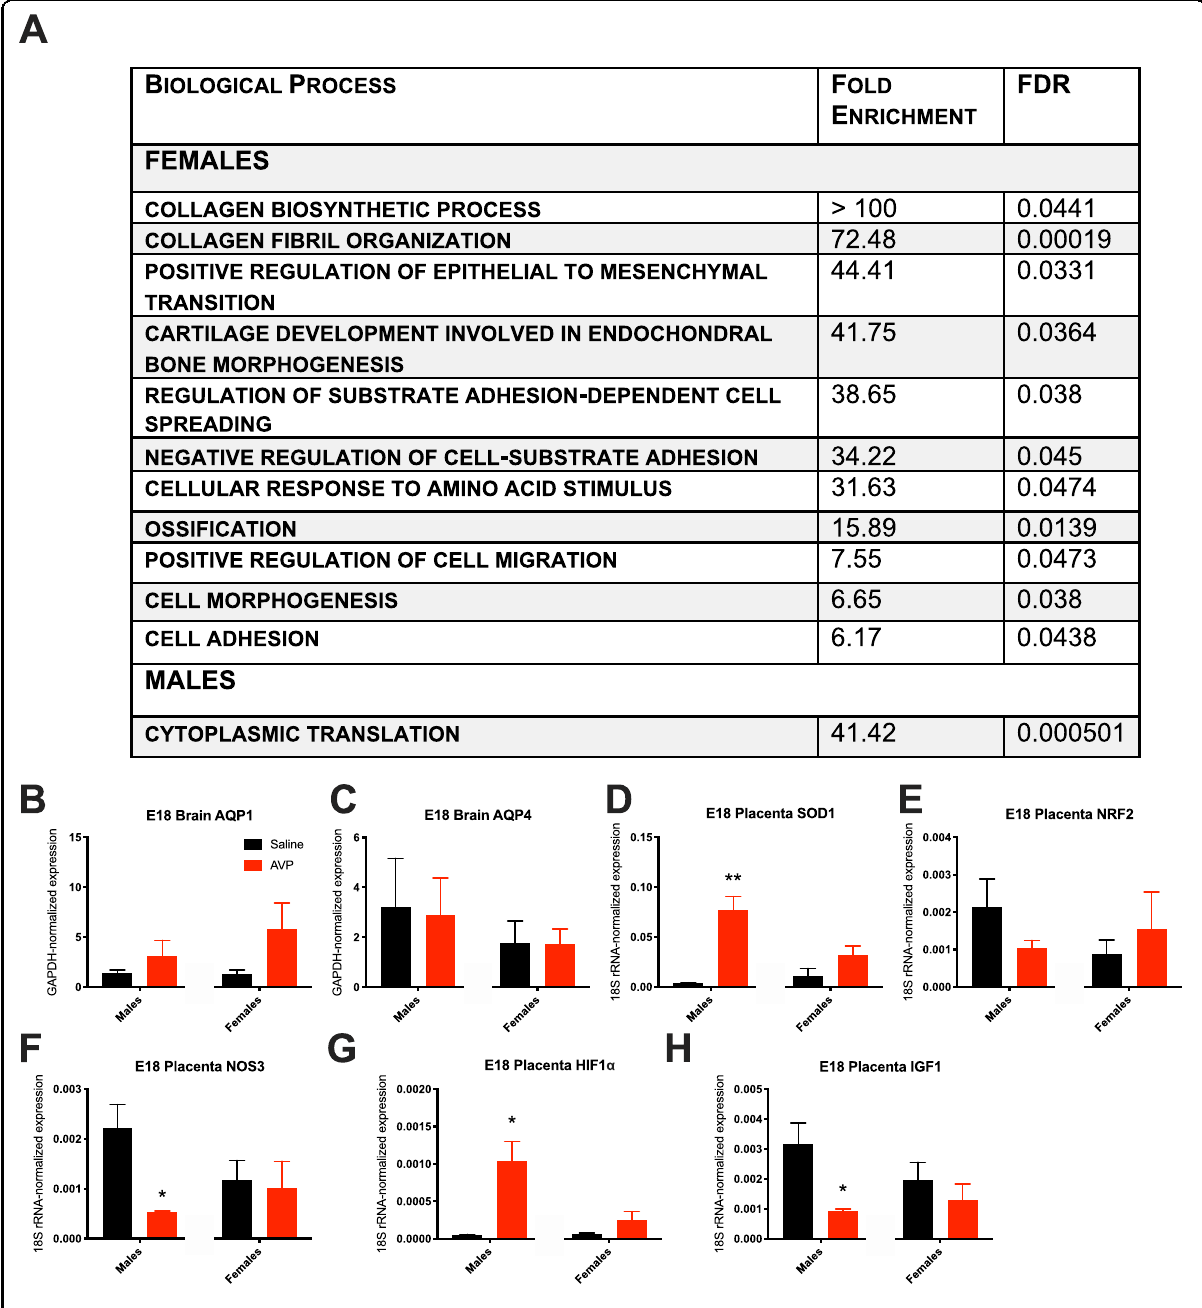
Fig. 5 Transcription indicates E18 cortical sex-speci fi c changes and E18 placental male-speci fi c redox and functional changes with maternal AVP. a Functional annotation of DE genes with AVP exposure revealed 11 DE biological processes in females and 1 in males with AVP exposure via PANTHERDB. n = 4 per group per sex except n = 3 for female AVP, excluding one outlier for high variance, each from an independent litter. b Embryonic day (E) 18 dorsal forebrain expression of Aquaporin 1 ( AQP1 ) and c Aquaporin 4 ( AQP4 ) were not changed by maternal AVP. d Transcript levels of superoxide dismutase ( SOD1 ) were signi fi cantly increased with AVP exposure in E18 placentas of AVP-exposed males ( p = 0.005). e Levels of erythroid 2 – related factor 2 ( NRF2 ) transcripts were unchanged. f An AVP male-speci fi c decrease occurred in placental nitric oxide synthase 3 ( NOS3 ) transcripts ( p = 0.021). g Placental hypoxia-inducible factor 1-alpha (HIF1 α ) expression increased with AVP exposure in male offspring ( p = 0.021). h Insulin-like growth factor 1 ( IGF1 ) expression decreased speci fi cally in males ( p = 0.031). * p < 0.05, ** p < 0.01 per two-sample t -test, error bars represent